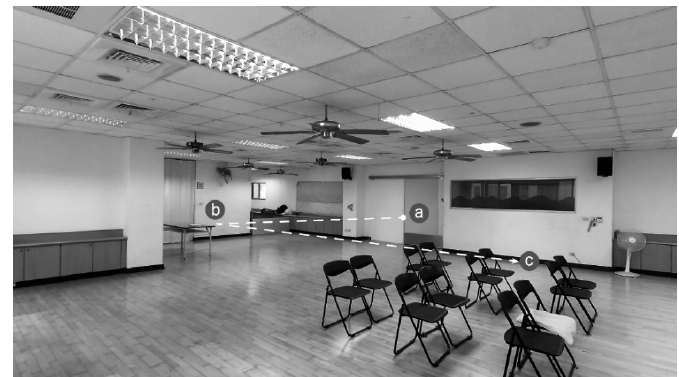
Figure 2. Exploration route of the spatial task.